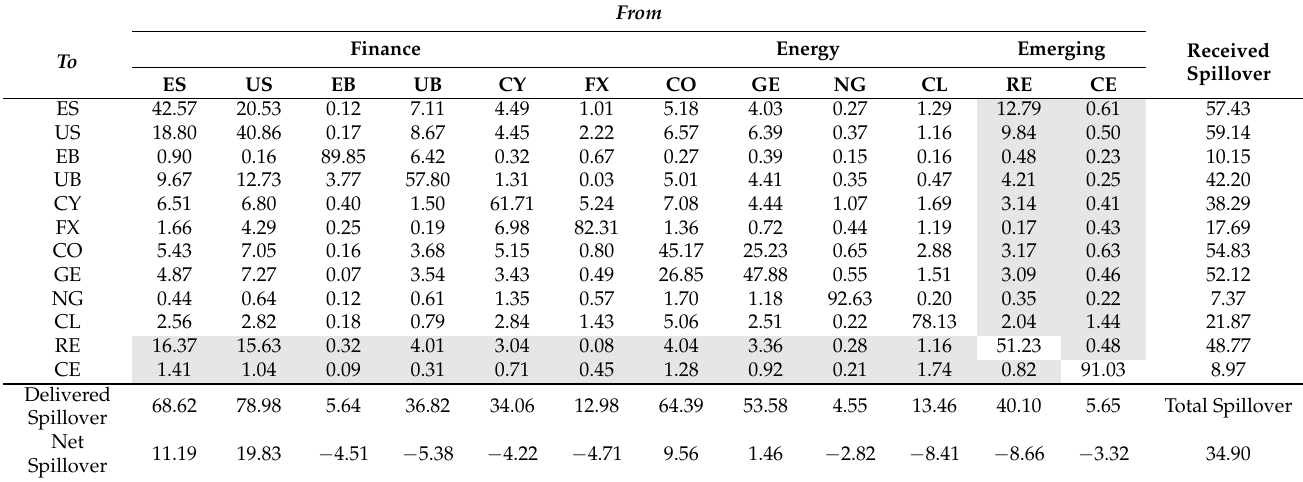
Table 3. Whole Period Return Spillover Indexes of Markets in the “Carbon–Renewable Energy–Finance–Energy” Mar- ket System. From Finance Energy To